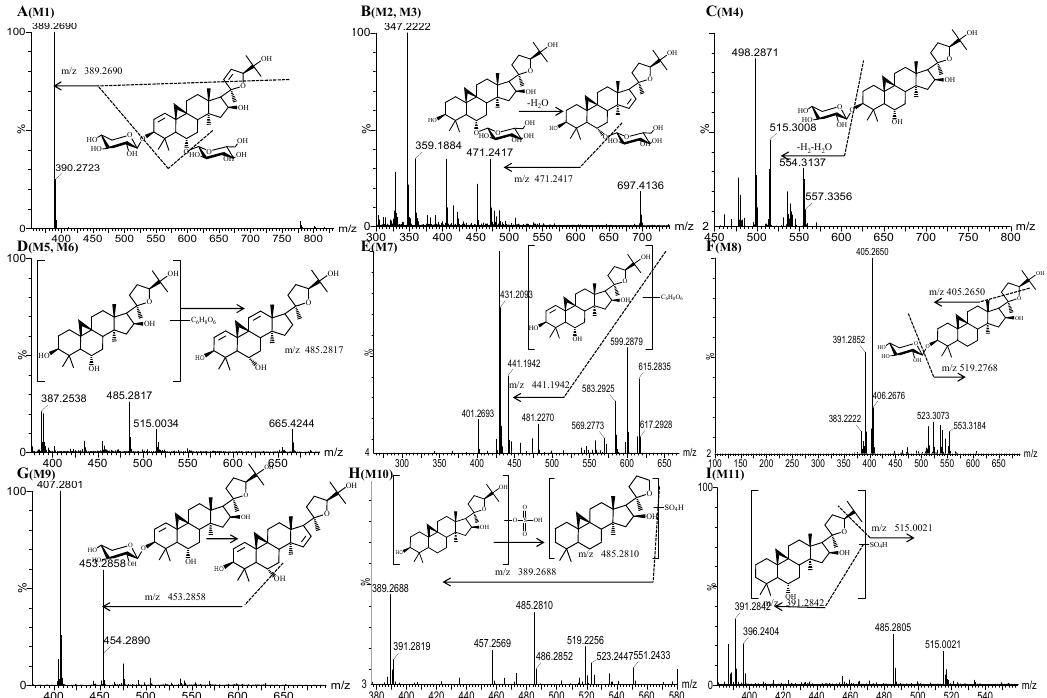
Figure 3. Mass spectra (MS/MS) of the metabolites of astragaloside